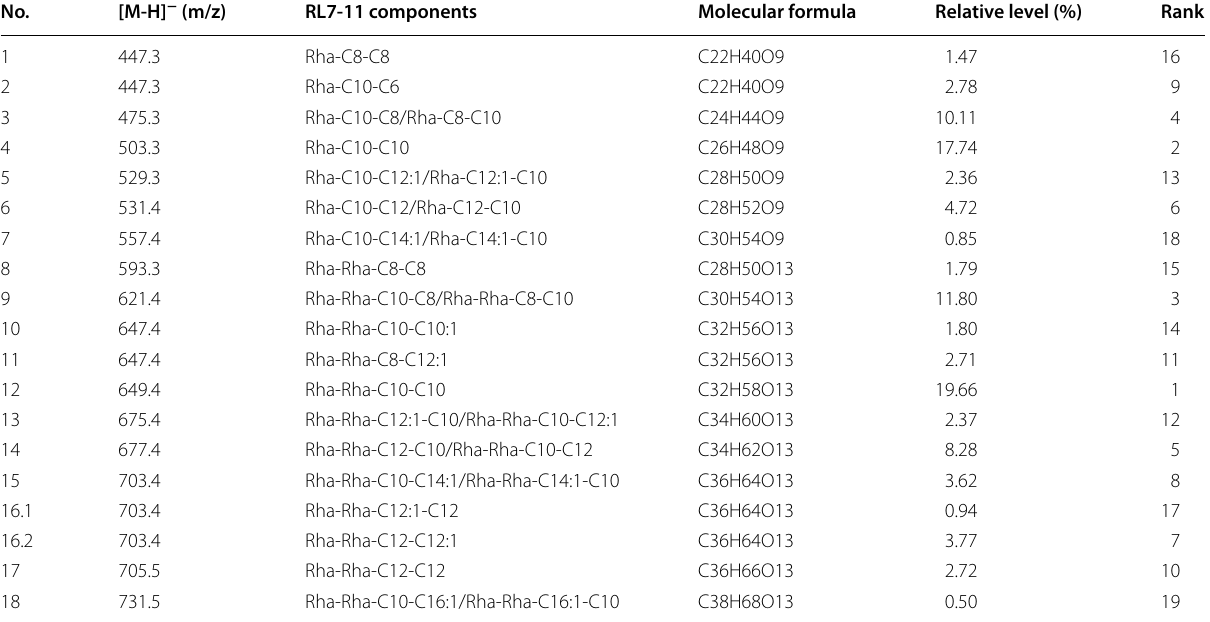
Table 1 Composition of rhamnolipids RL7-11 produced by P. aeruginosa ZS1